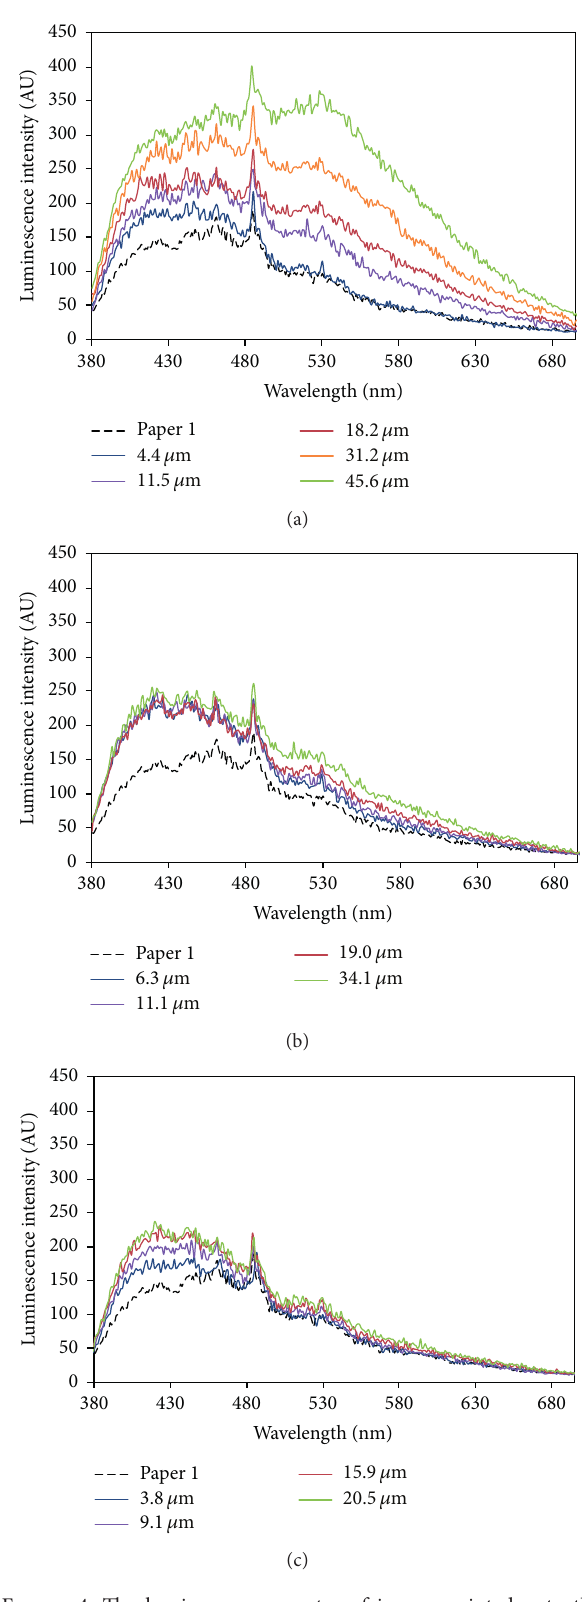
Figure 4: The luminescence spectra of images printed onto the paper with the minimum content of OBAs (paper 1) using the ink compositions with the following contents of the fluorescent component (ZnO nanoparticles): (a) 0.15%; (b) 0.1%; (c)